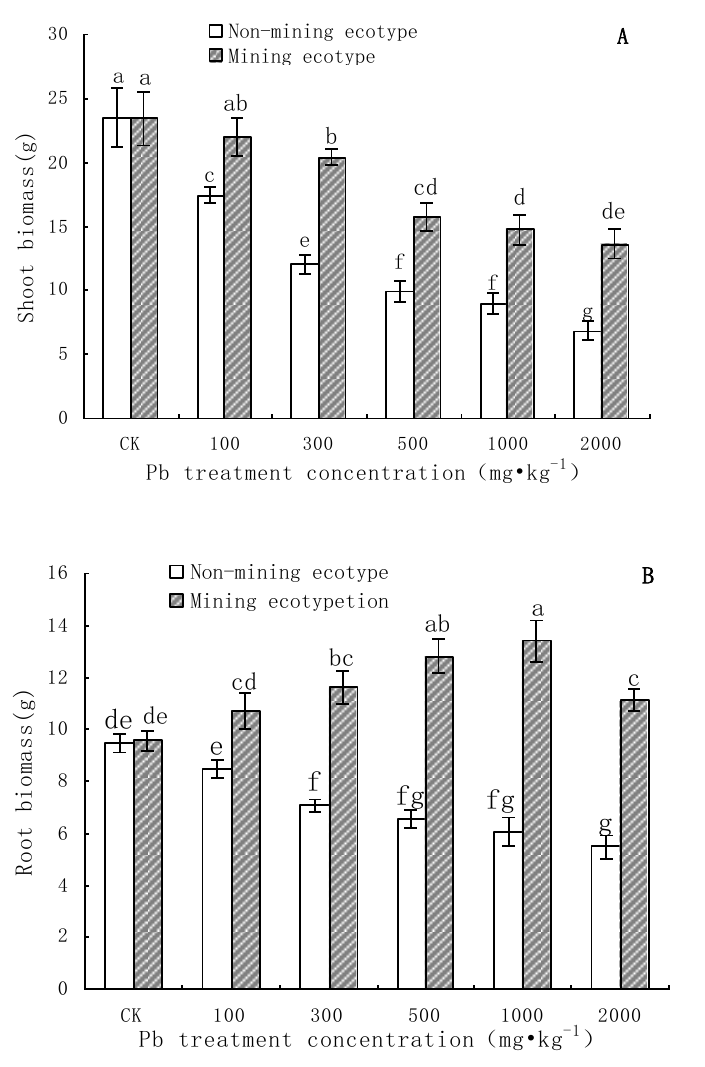
Figure 3. Root biomass and shoot biomass of two ecotypes of M. floridulus under different Pb treatment (( A ) is shoot biomass, ( B ) is root biomass). Note: Error bars indicate standard deviation; different letters in the same group indicate significant difference at p < 0. 05 according to Duncan’s multiple range tests.